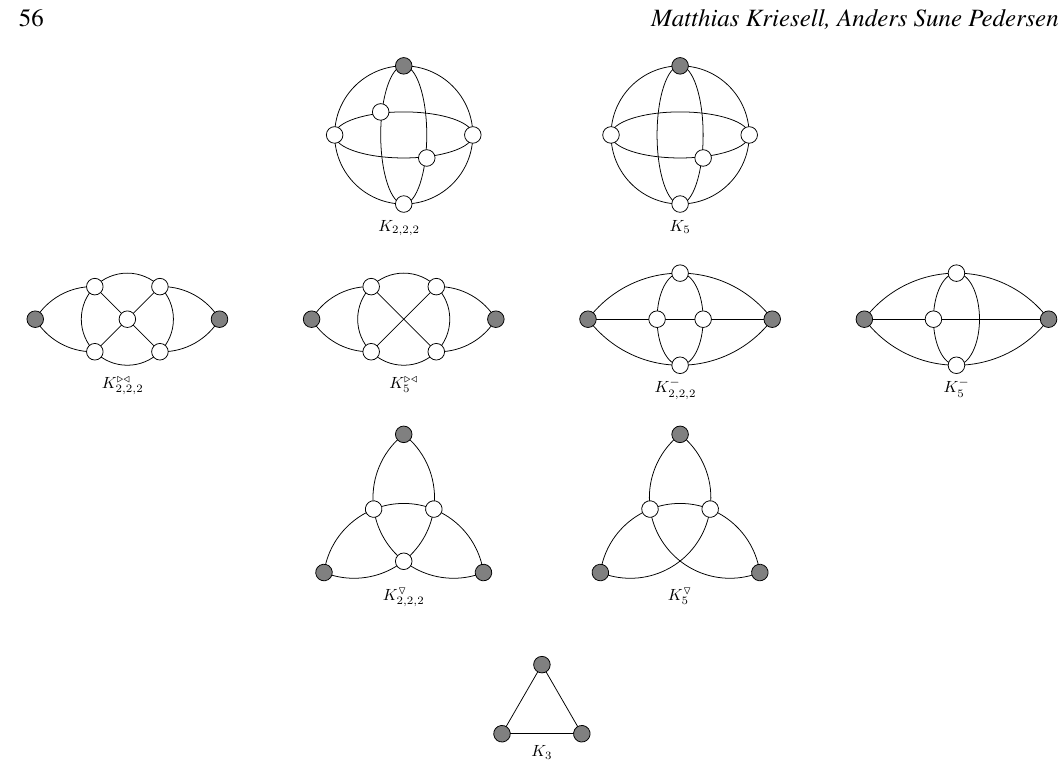
Fig. 2: The nine bricks. Vertices of attachment are displayed